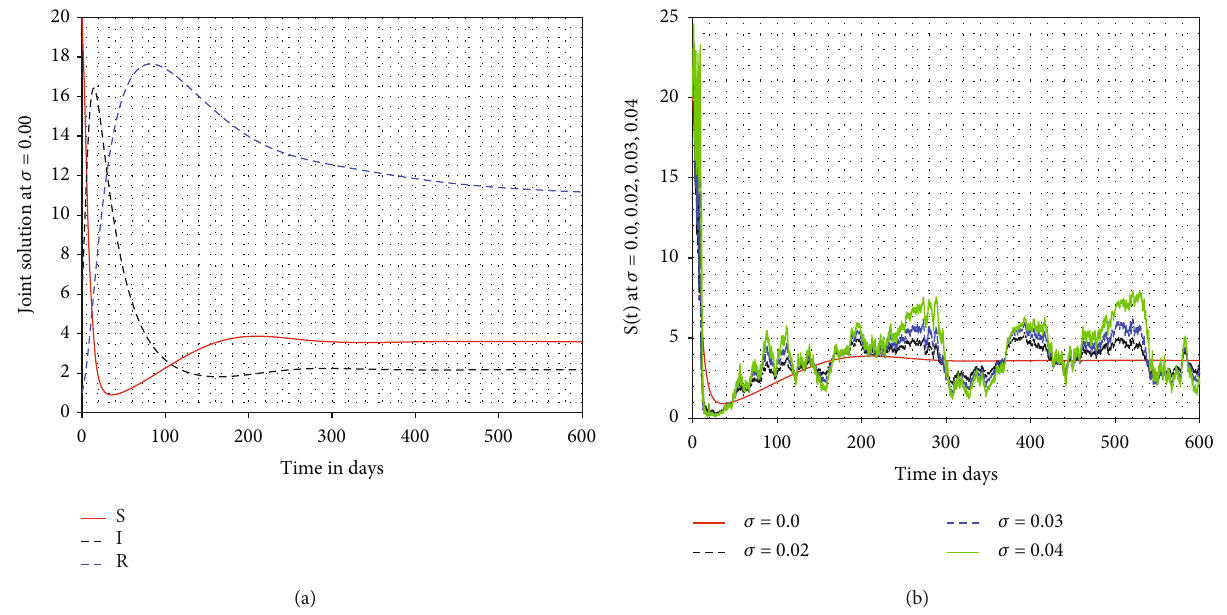
Figure 1: (a, b) Joint solution of (1) at σ = 0 : 0 and S ð t Þ .